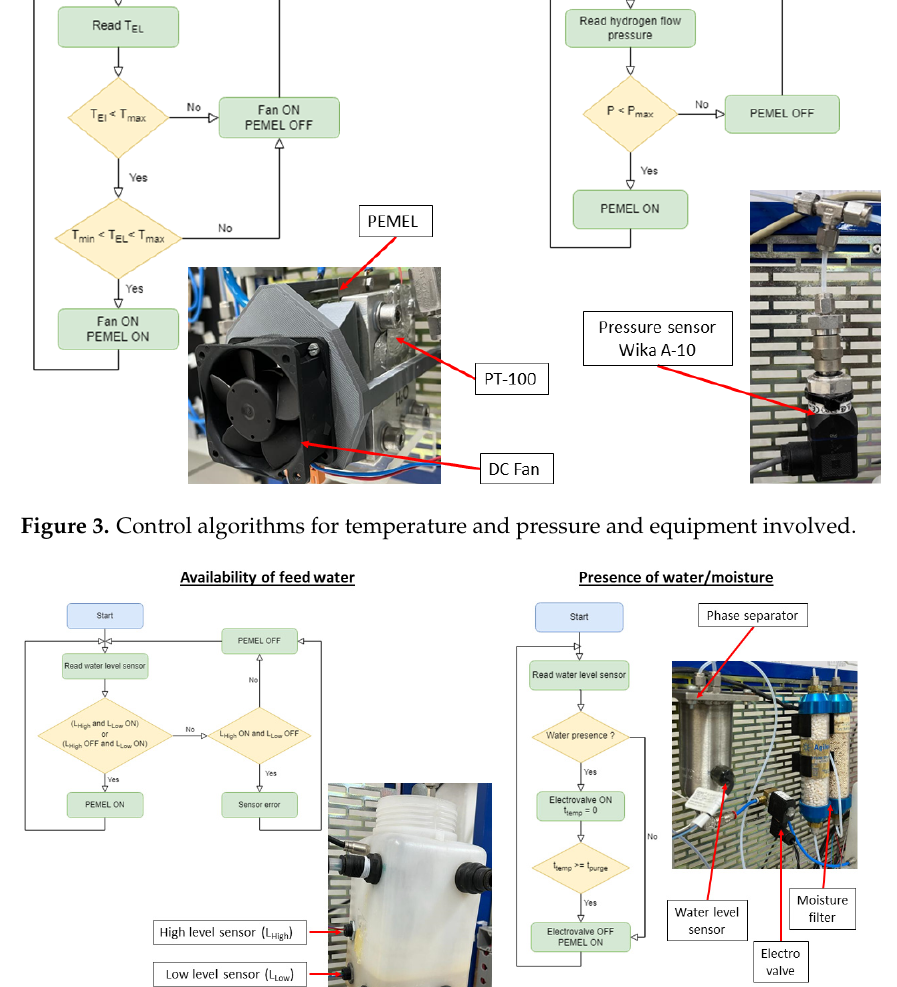
Figure 3. Control algorithms for temperature and pressure and equipment involved.